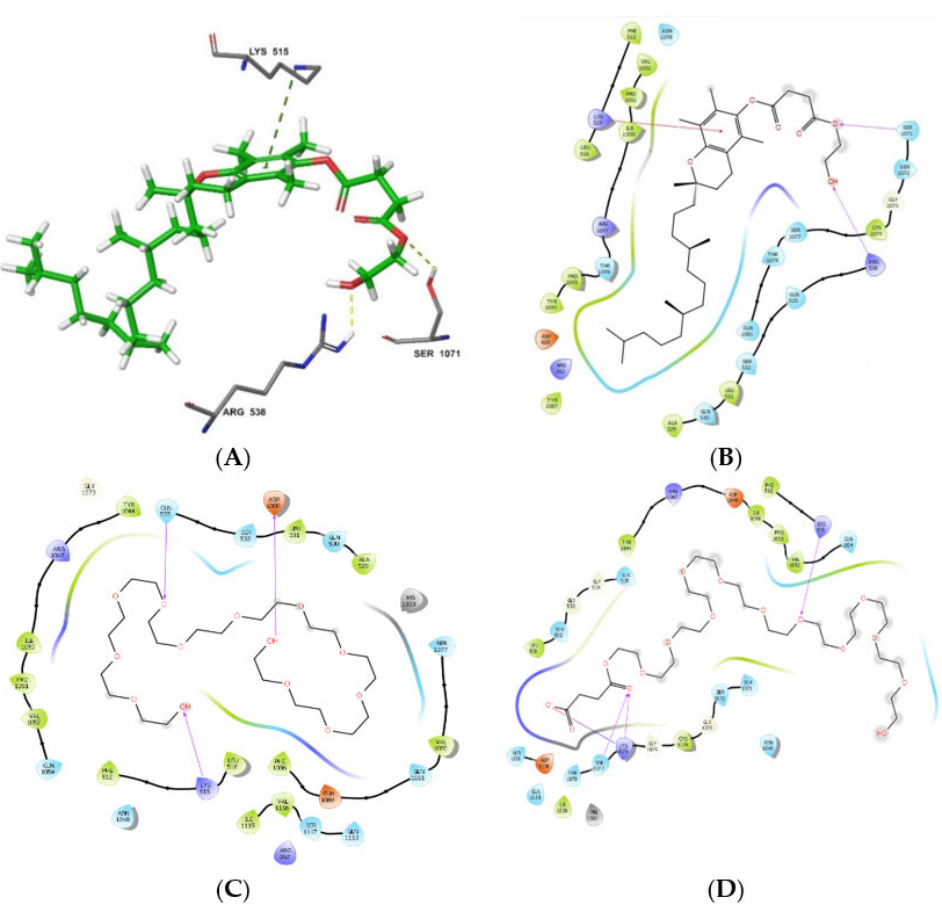
Figure 15. Molecular interactions of PEG and TPGS with P ‐ gp ATP ‐ binding site. ( A ) Shows predominant bonds stabilizing TPGS in a required pose and ( B ) highlights all amino acid residues in possible interaction with TPGS. ( C , D ) Respectively display the molecular interactions of PEG with PEG succinate with P-gp active